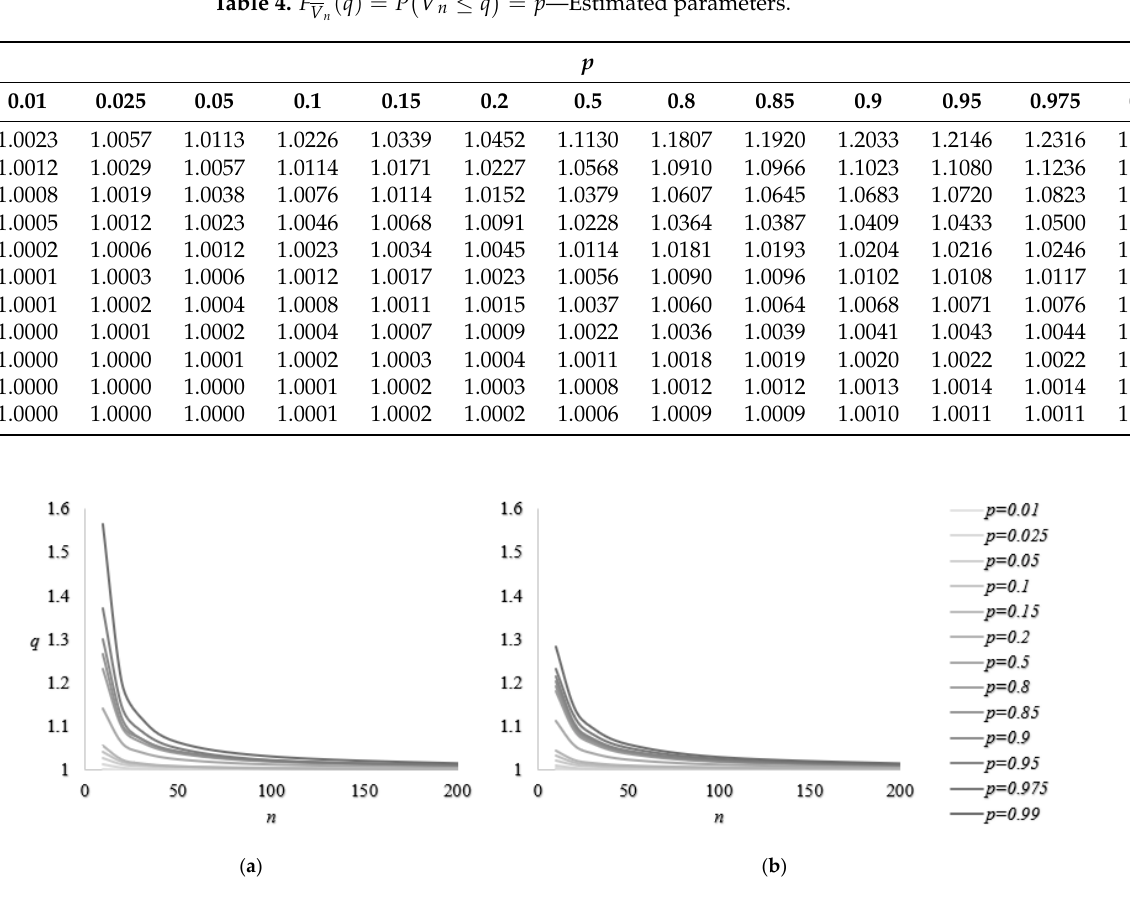
(𝑞) = 𝑃(𝑉(cid:3364) (cid:3041) ≤ 𝑞) = 𝑝 —Estimated parameters. Table 4. 𝐹 (cid:3023)(cid:3365) (cid:3289)